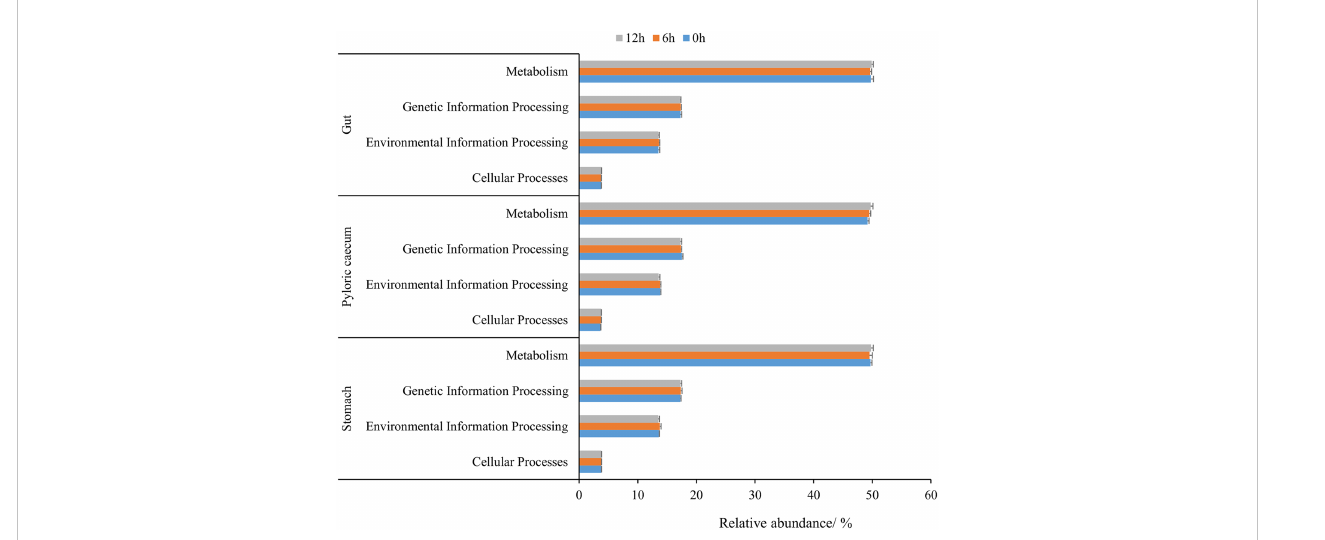
FIGURE 7 The dominant KEGG pathway of gastrointestinal microbiota of pond-cultured Japanese fl